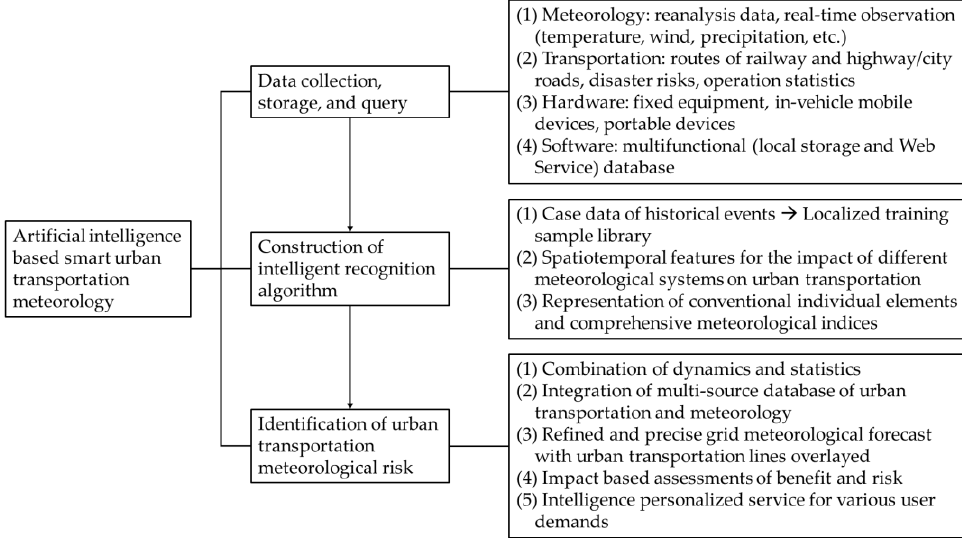
Figure 2. Detailed procedures of artificial intelligence-based smart urban transportation meteorol- ogy system.